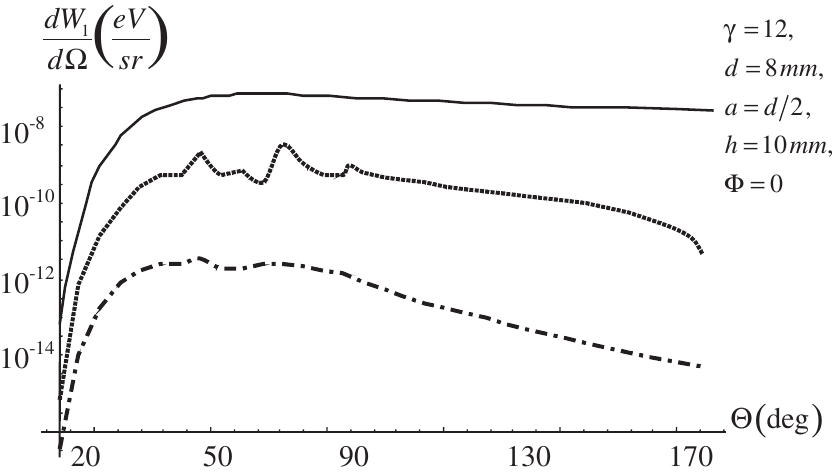
FIG. 6. The angular distribution of the SPR intensity for a thin grating with vacuum gaps: a solid line for the RDR model; a dotted line ( b=d (cid:5) 1 = 8 ) and a dash-dotted line ( b=d (cid:5) 0 : 001 (cid:7) for van den Berg‘s model.